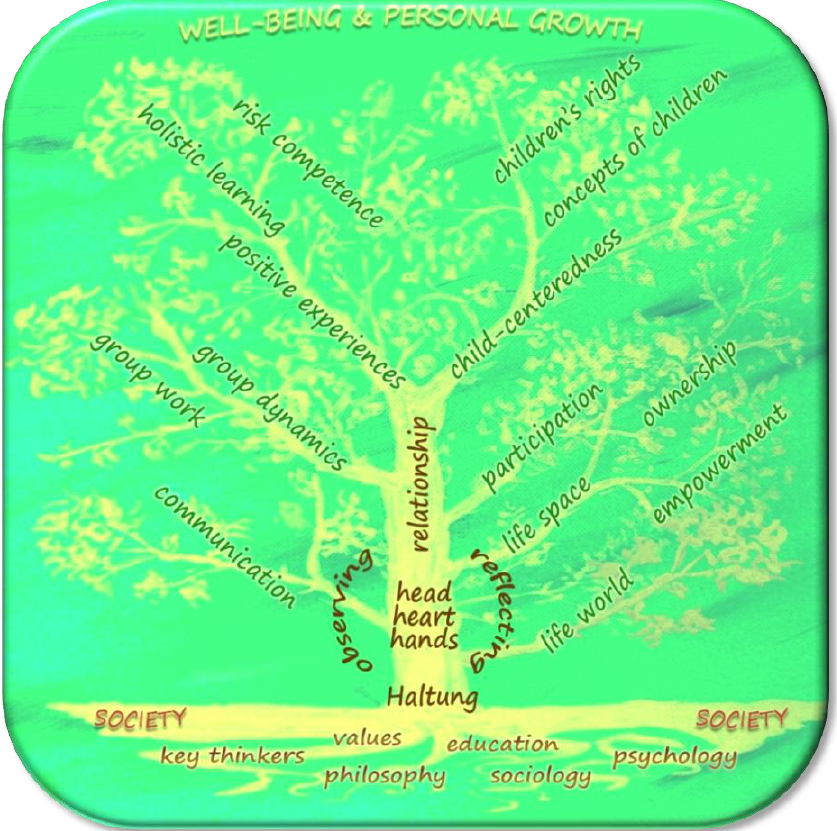
Figure 1: The Social Pedagogy Tree (Eichsteller &